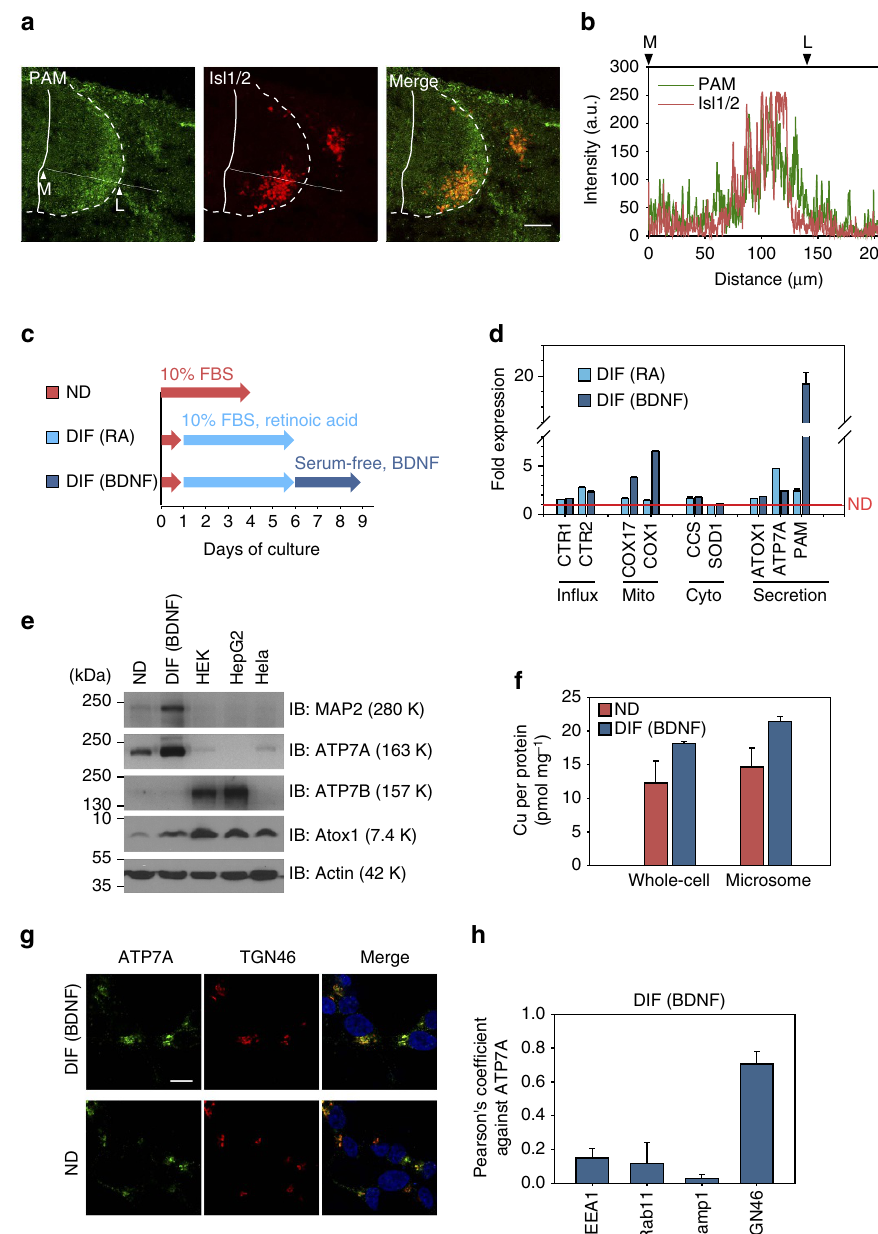
Figure 1 | Requirement for copper is increased in the secretory pathway upon neuronal differentiation. ( a ) Immunostaining of PAM (green) in a chicken spinal cord (HH stage 20 embryo). Traverse sections of chick embryos were analysed. Differentiated cells in marginal zones were identified by postmitotic marker isl1/2 (red). Scale bar, 50 m m. ( b ) Intensity profile along the line indicated by the arrow in a shows overlap between PAM and Isl1/2 expression. Medial and lateral borders are represented as M and L, respevtively. ( c ) Schematic of differentiation of SH-SY5Ycells by sequential treatments with retinoic acid (DIF RA) and BDNF (DIF BDNF). ( d ) Differentiation is associated with upregulation of genes involved in copper fluxes to mitochondria and,